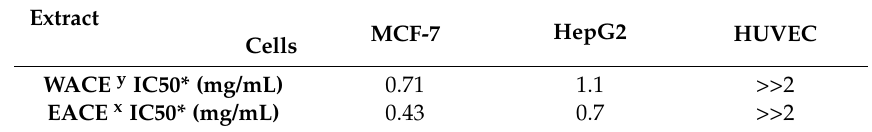
Table 2. IC50* of grape leaves ethanolic and water ASE crude extracts on MCF-7, HepG2 and HUVEC